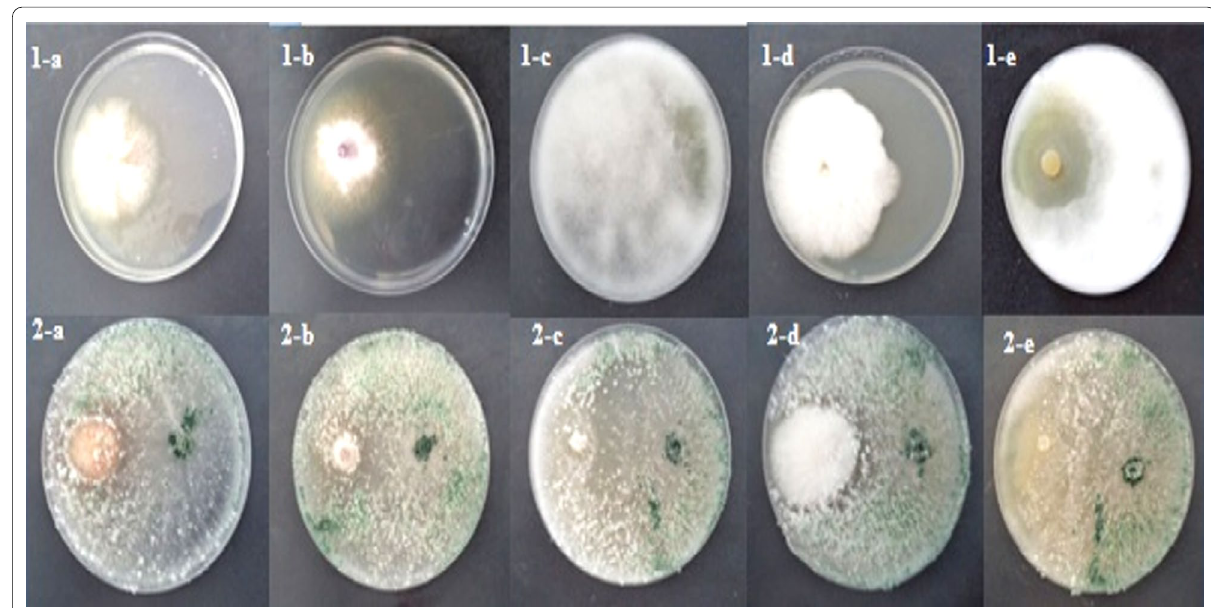
Fig. 2 Comparison between control colonies (1) of Fusarium solani ( a ), F. oxysporum ( b ), Pythium ultimum ( c ), Phytophthora citrophthora ( d ) and Phytopythium mercuriale ( e ) and their colonies confronted with Trichoderma harzianum (T10) (2) after 5 days of incubation at 25